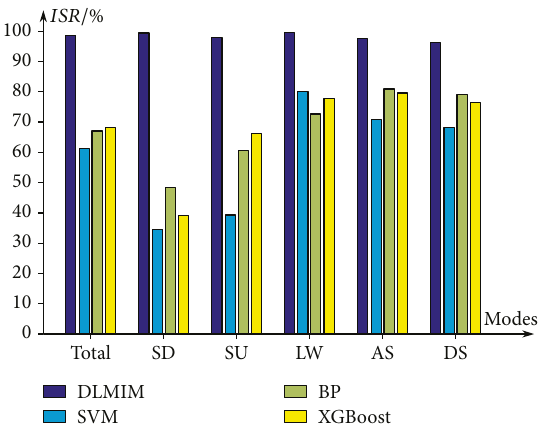
Figure 9: ISR comparison between di ff erent locomotion mode identi fi cation models.